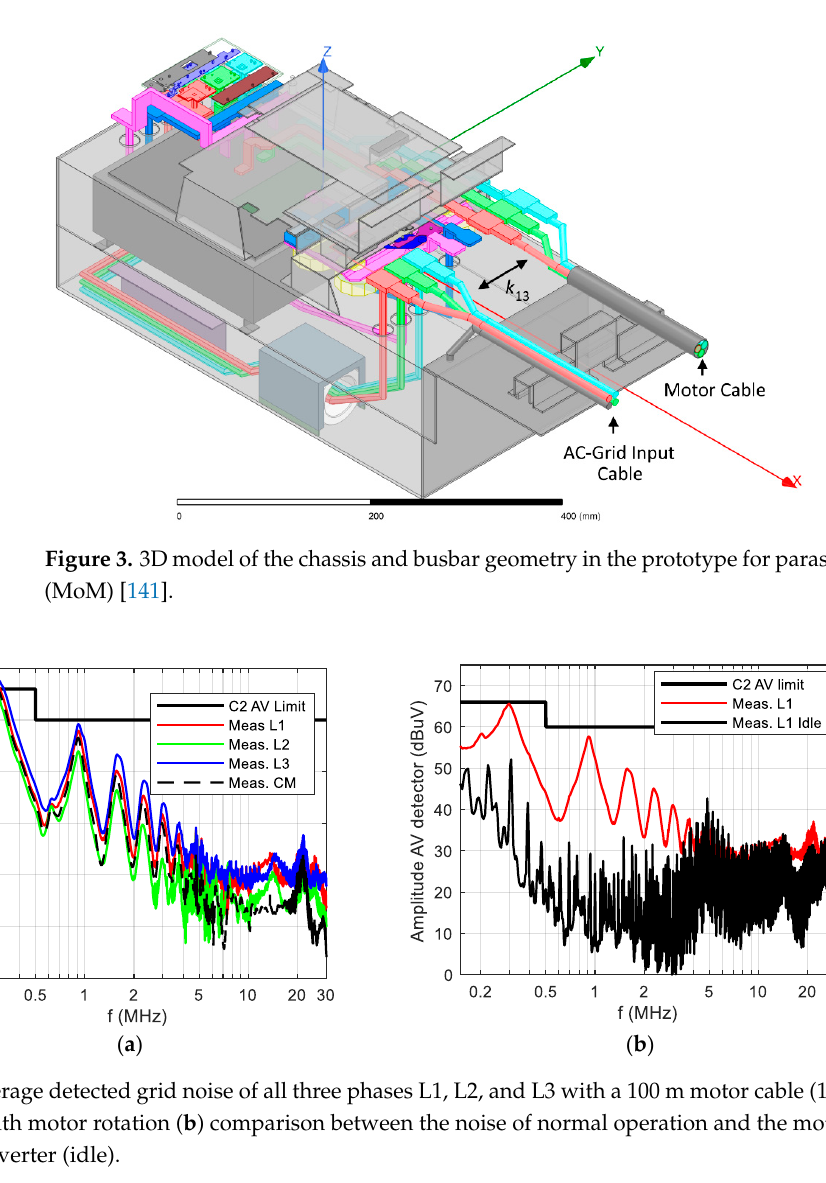
Figure 3. 3D model of the chassis and busbar geometry in the prototype for parasitic RLGC extraction (MoM) [141].